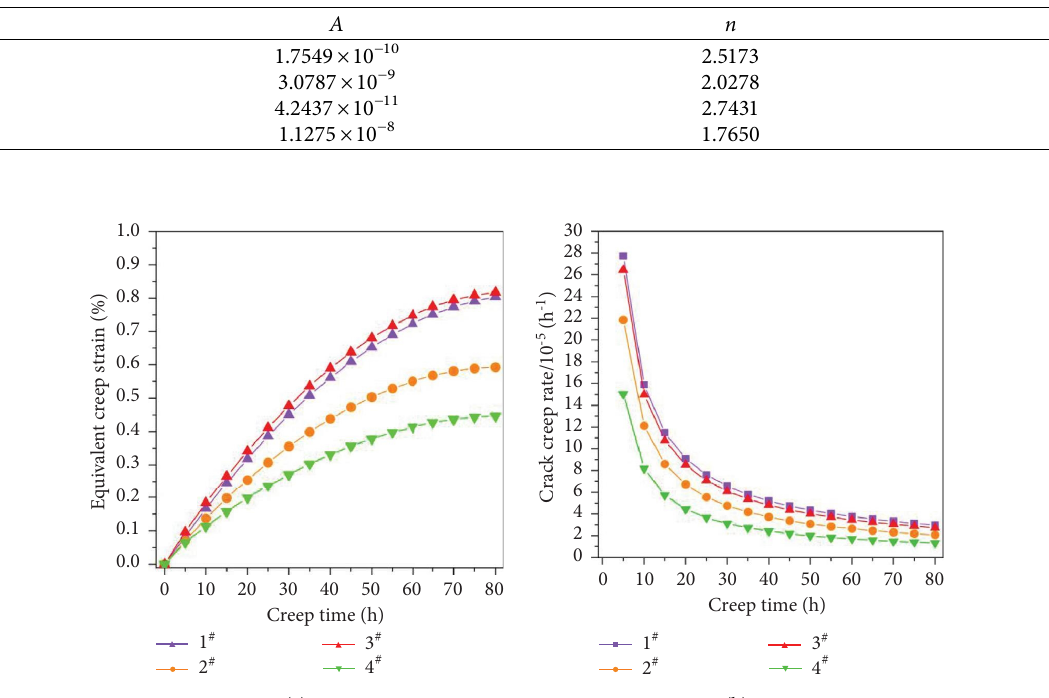
Figure 7: Creep characteristics at the crack tip of Ti-6Al-4V alloy at diferent forging temperatures: (a) creep curve; (b) creep